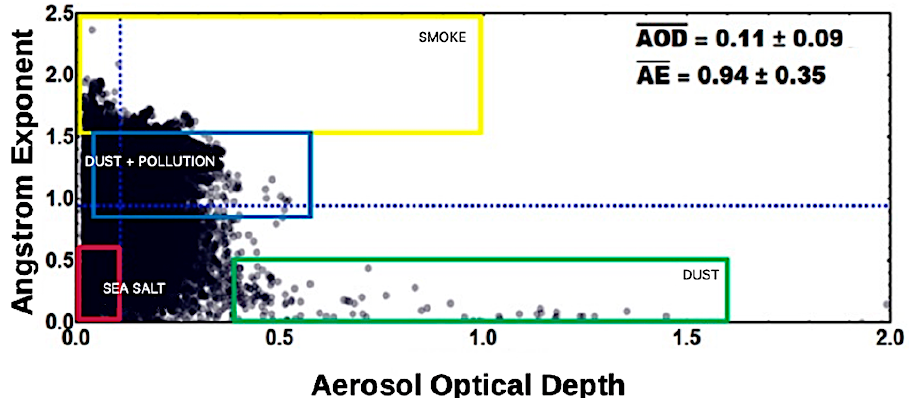
Figure 7. Scatter plot of Aerosol Optical Depth versus Angström Exponent for the period from 2007 to 2016 at Petrolina-PE. The colored boxes represent the different aerosol types found at the AERONET site.